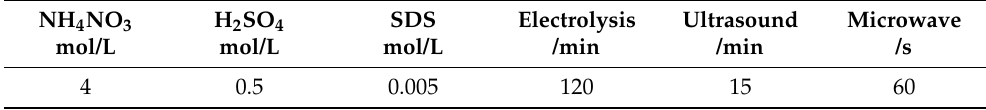
Table 1. Electrolyte concentration and subsequent treatment